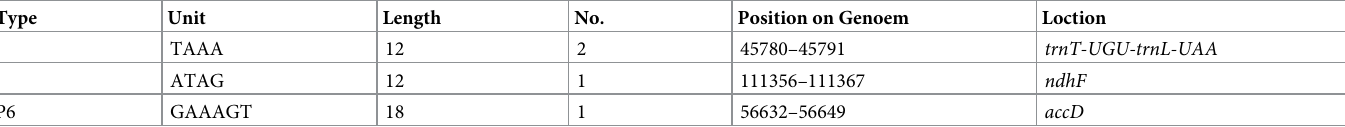
(Table 4). The longest SSR was a 22 bp long mononucleotide repeat located within ycf1 . Only A-type (12 SSRs) and T-type (21 SSRs) mononucleotide repeats were observed. AT/TA was present in all 12 dinucleotide repeats, and the longest type of dinucleotide repeat was AT (20 bp). The unique trinucleotide repeat was ATT (12 bp), which was found in the intergenic spacer IGS region between trnT-UGU and trnL-UAA . Three tetranucleotide repeat types (CAAA, TAAA, and ATAG) and one hexanucleotide repeat (GAAAGT) were also detected in the M . arvensis cp genome. Among the SSR loci, 32 were found in the intergenic spacer IGS regions, accounting for 62.75% of the total SSRs. The remaining SSR loci were distributed in 11 genes, and the pseudogene ycf1 harbored most SSRs (six SSR